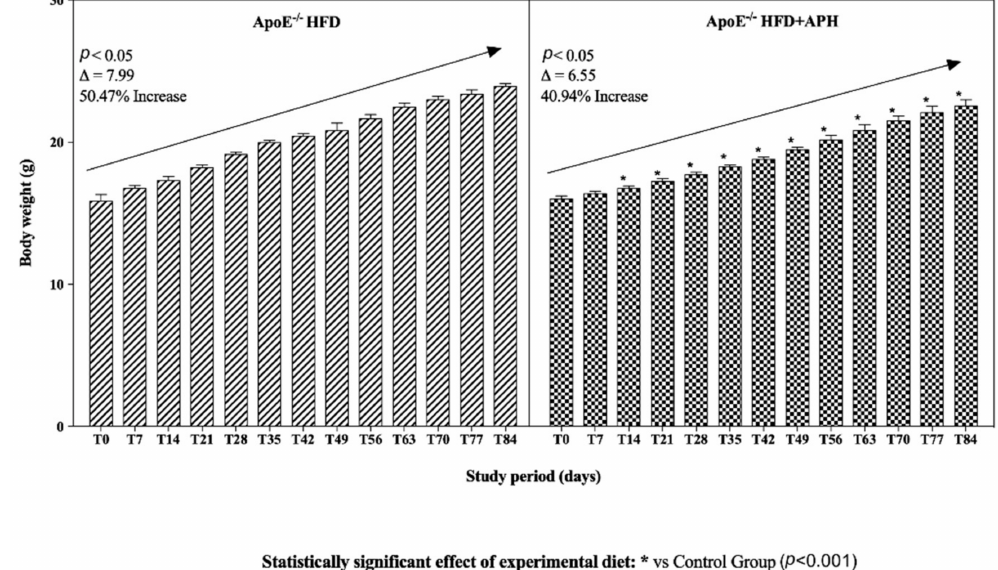
Figure 1. Body weight trends in mice throughout study period. An increasing trend in body weight was observed in ApoE – / – mice of both groups ( p < 0.05), with a percentage increase of 50.47% in ApoE – / – mice fed HFD and 40.94% in ApoE – / – fed HFD + APH. Body weight gain was significantly lower in ApoE – / – fed HFD + APH from T14 to T84 compared to the control group ( p < 0.001). Data are presented as mean ± SD for n = 6 mice per group. Abbreviations: HFD high-fat diet, APH anchovy protein